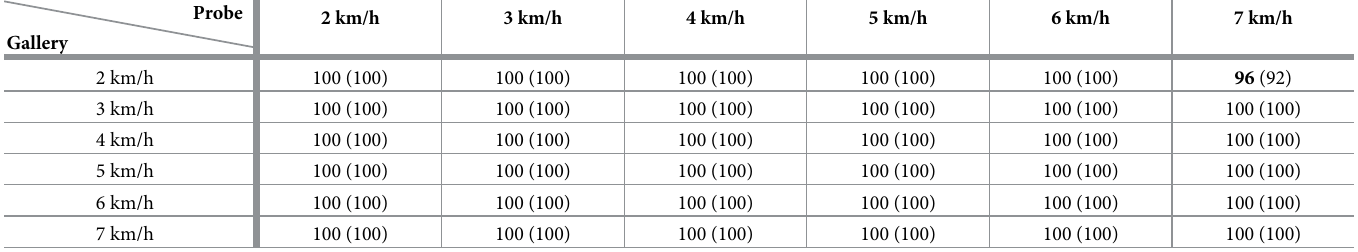
Table 4. CCR [%] of the B-2D-PCA-R MSM and the MSM-based method with divided areas [12] (numbers in round brackets) in the cross-speed walking gait recognition. Gallery